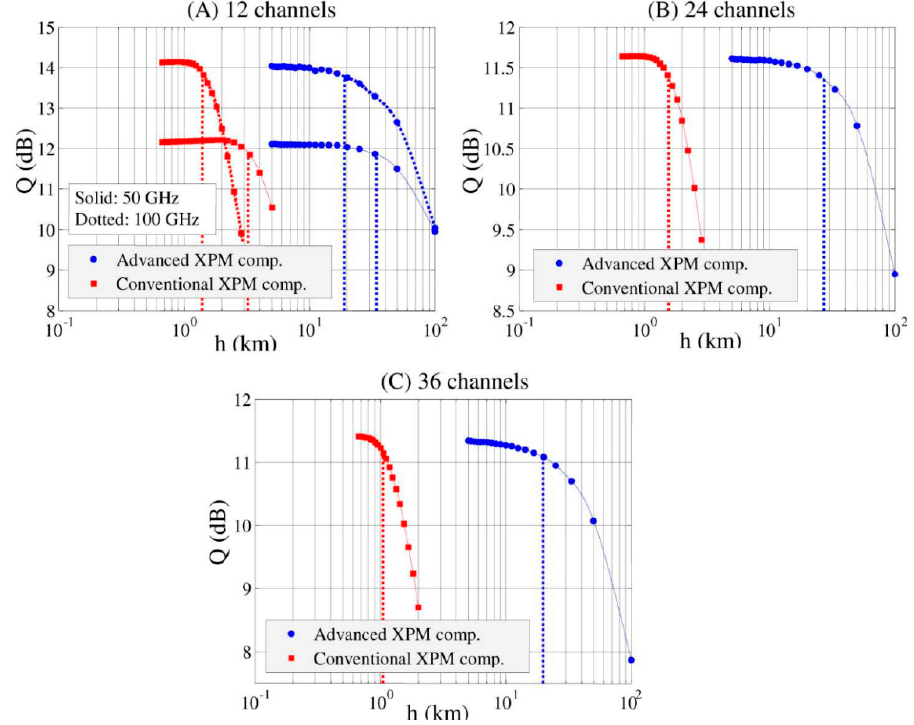
Figure 12. Step size for the advanced and conventional implementation of the split-step Fourier method (SSFM): ( A ) 12 channels, ( B ) 24 channels and ( C ) 36 channels respectively.